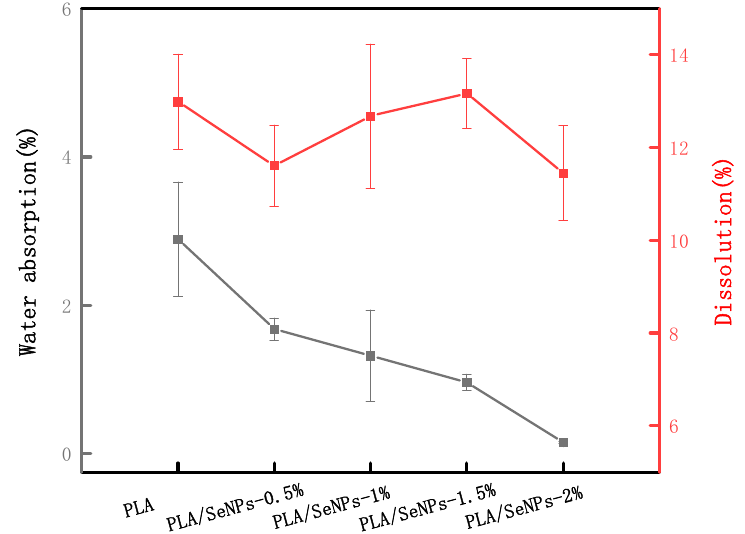
Figure 4. Water absorption and dissolution rate of different composite films.